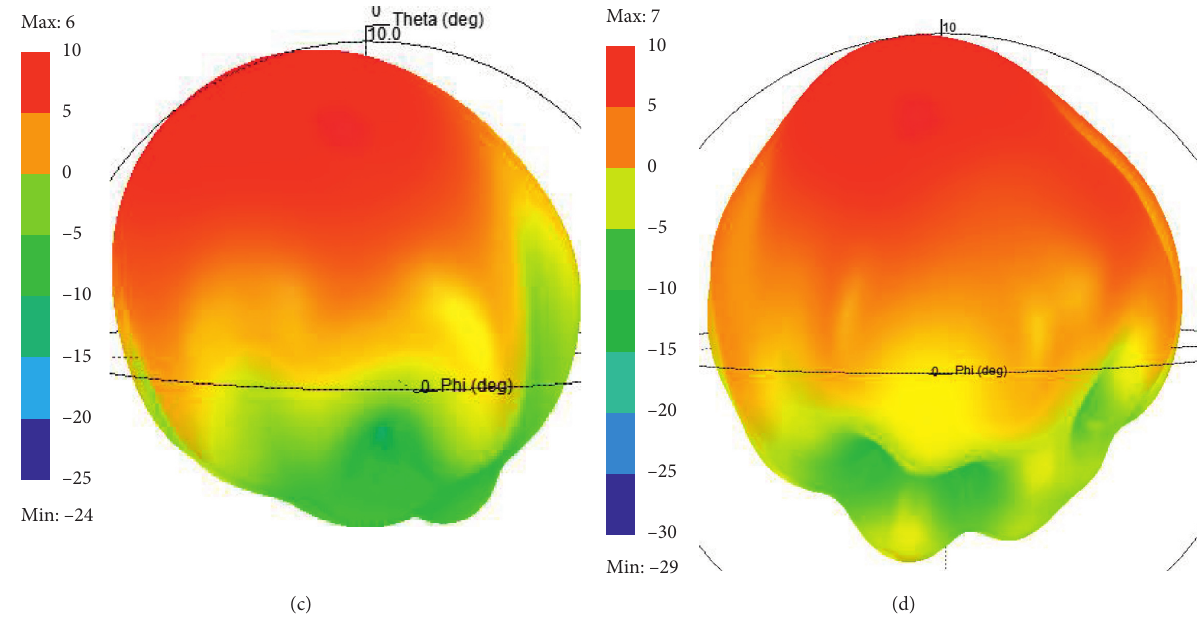
� 8mm; (c) f � 3.6GHz; F y